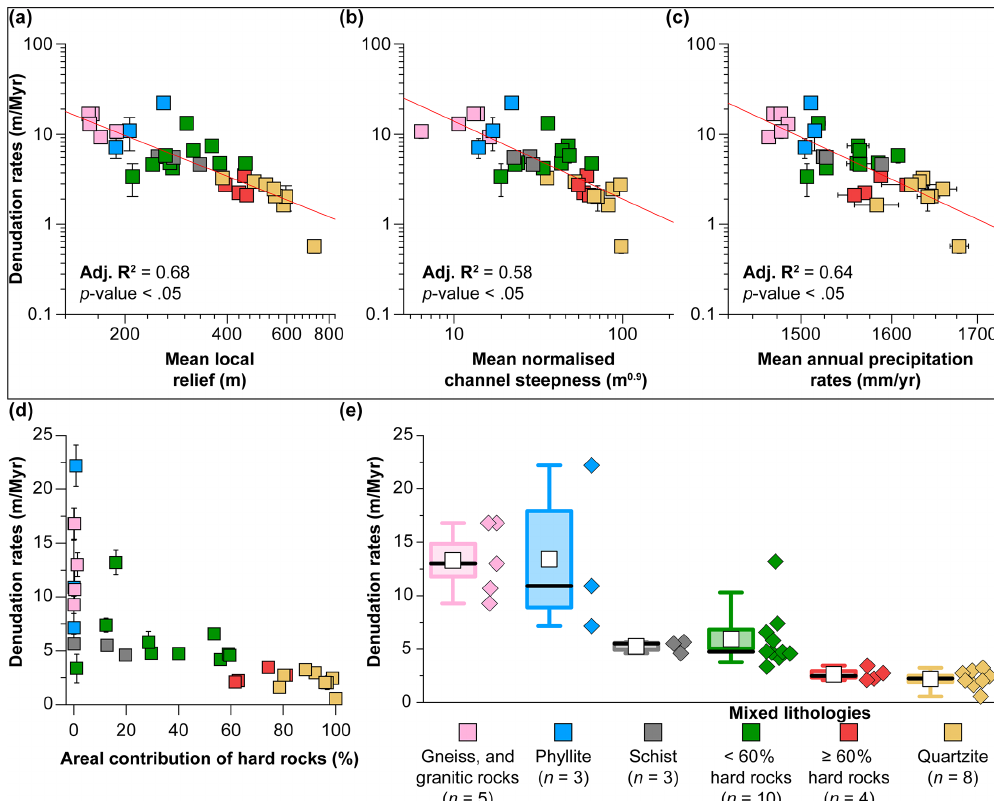
Figure 4. Links between denudation rates, geomorphic parameters, and rock type in the study area. Variations in catchment-averaged denudation rates with (a) mean local relief, (b) mean normalised channel steepness, (c) mean annual precipitation rates, and (d) percentage areal contribution of resistant rocks. Error bars on the y axis show measurement uncertainties in the nuclide concentration, as well as uncertainties related to the scaling method, and error bars on the x axis indicate the standard error of the mean. (e) Variations in catchment- averaged denudation rates per rock type, with the box on the left and raw data (diamonds) on the right. Box range represents the standard error of the mean, whiskers show the interval between the 10th and 90th percentiles of the data, white squares show mean values, and thick black lines exhibit median values. Mixed lithology refers to catchments where a single lithology does not account for ≥ 75% of the catchment